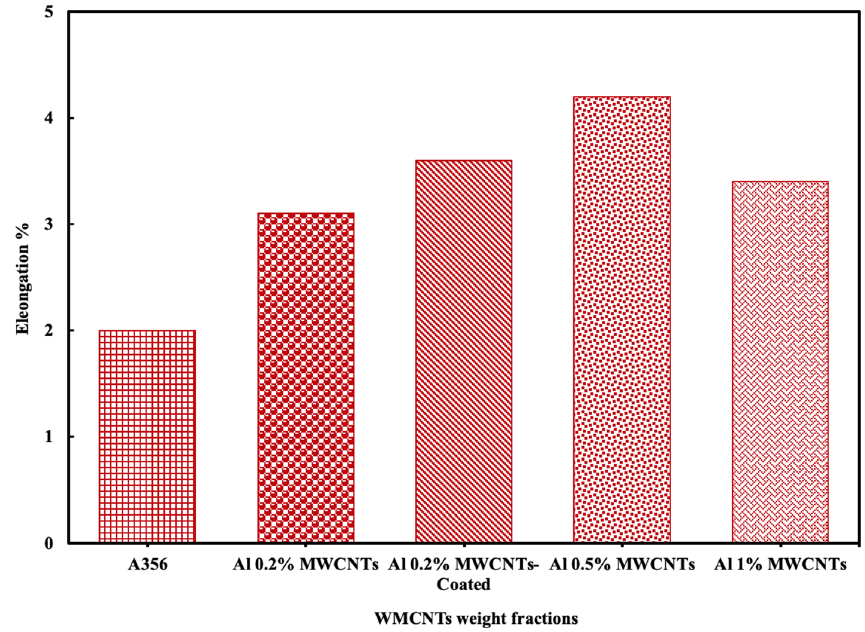
Figure 8. Effect of MWCNTs with different percentages on the elongation percentage of the A356 composite. Table 4. Percentage increase in yield stress, tensile resistance, hardness, and elongation of fabricated nanocomposites compared with A356 aluminum alloy.